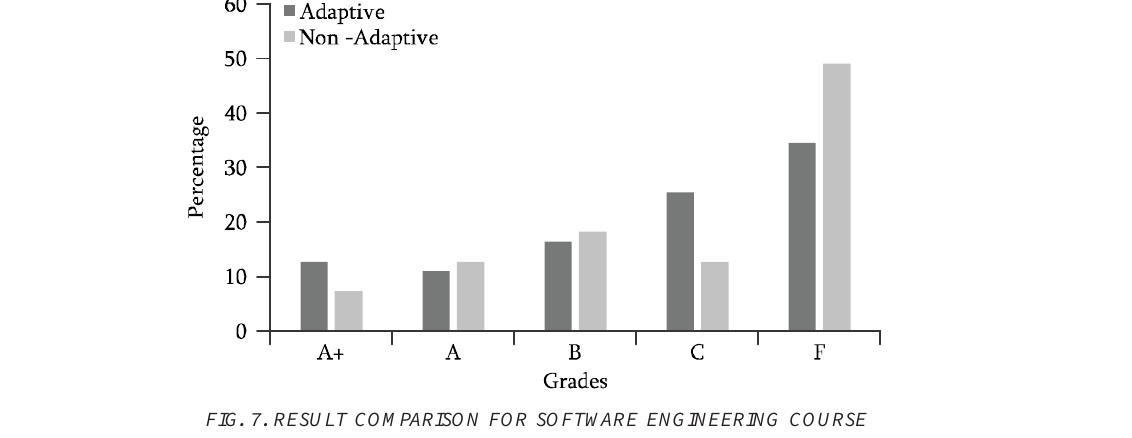
FIG. 7. RESULT COMPARISON FOR SOFTWARE ENGINEERING